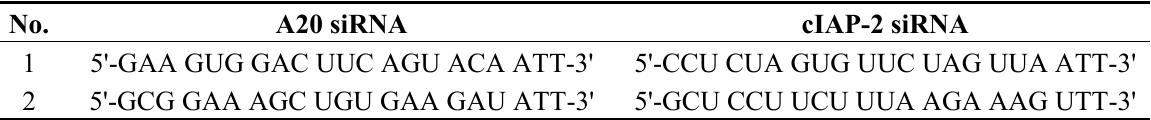
Table 1. The sequences of the